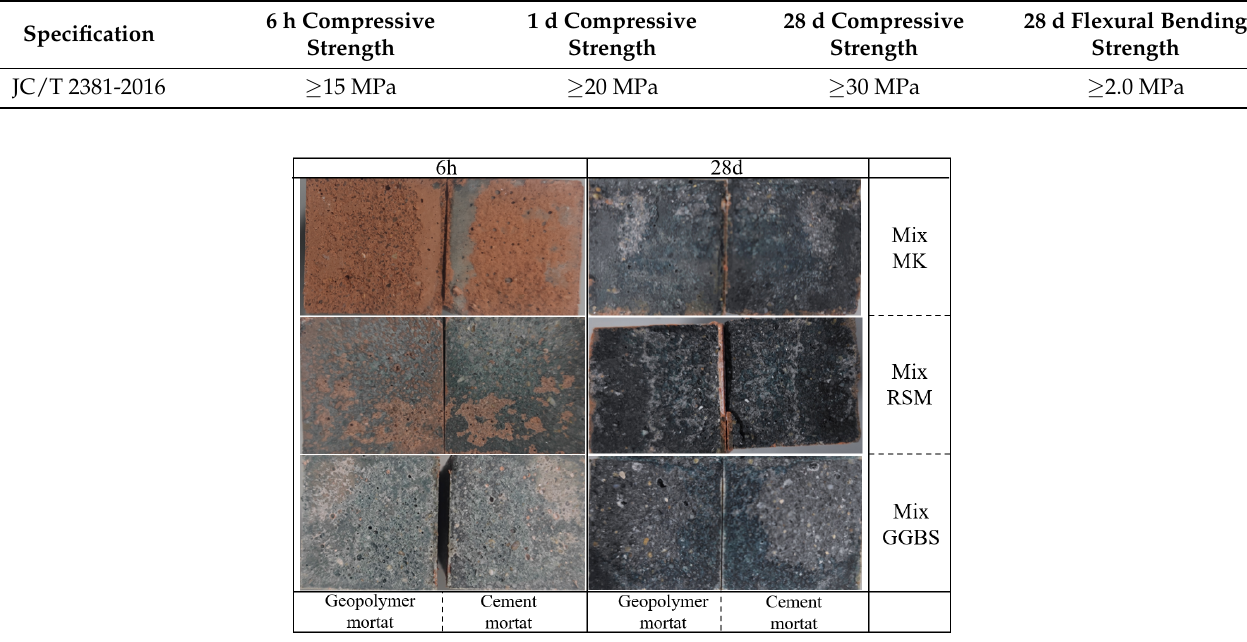
Figure 19. Fracture surface diagram of flexural bending strength specimen. Table 9. Bond strengths of different types of repair material. Table 9. Bond strengths of different types of repair